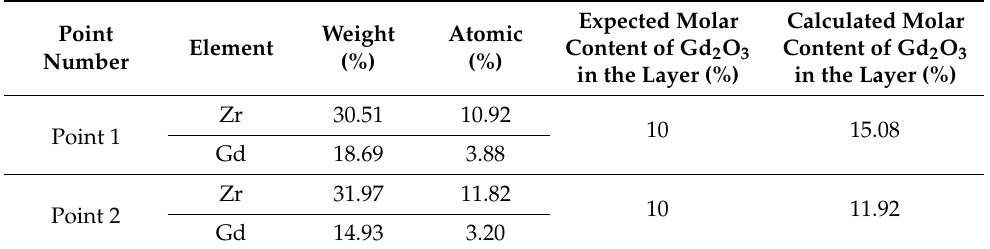
Figure 2. ZrO 2 -Gd 2 O 3 layer deposited at 550 ◦ C. Magnification: × 20,000 ( a ) and magnification: × 40,000 ( b ). Molar content of Gd(tmhd) 3 in the gas reaction mixture: 20%. Synthesis time: 30 min. The layer was also non-porous and contained Zr and Gd (Table 2). Table 2. Average chemical composition carried out by EDS point analysis at points 1 and 2 presented in Figure